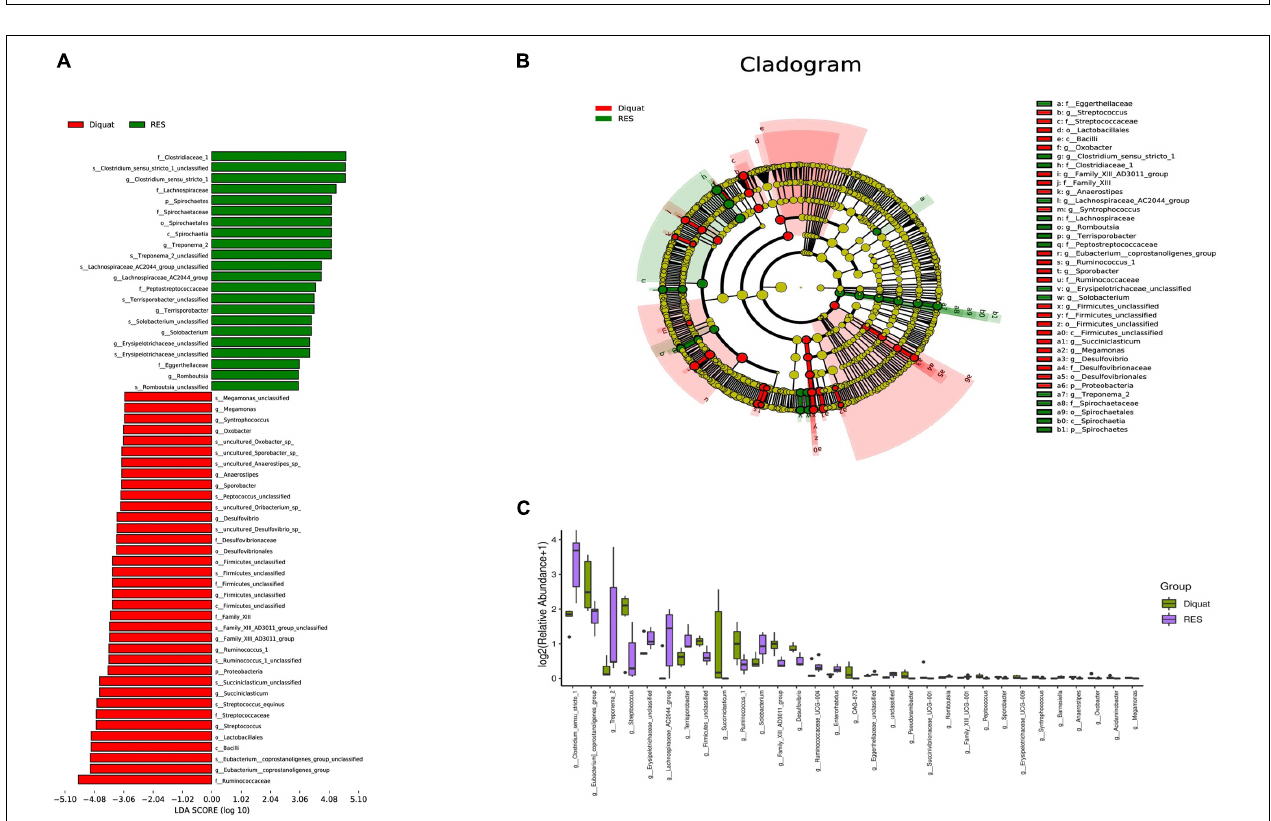
FIGURE 3 | Gut microbiome significantly different microbe analysis. (A,B) Significantly different microbes (A) and the cladogram (B) by LEfSe analysis. (C) Barplot shows microorganisms with significant differences at genus level between diquat and RES groups.